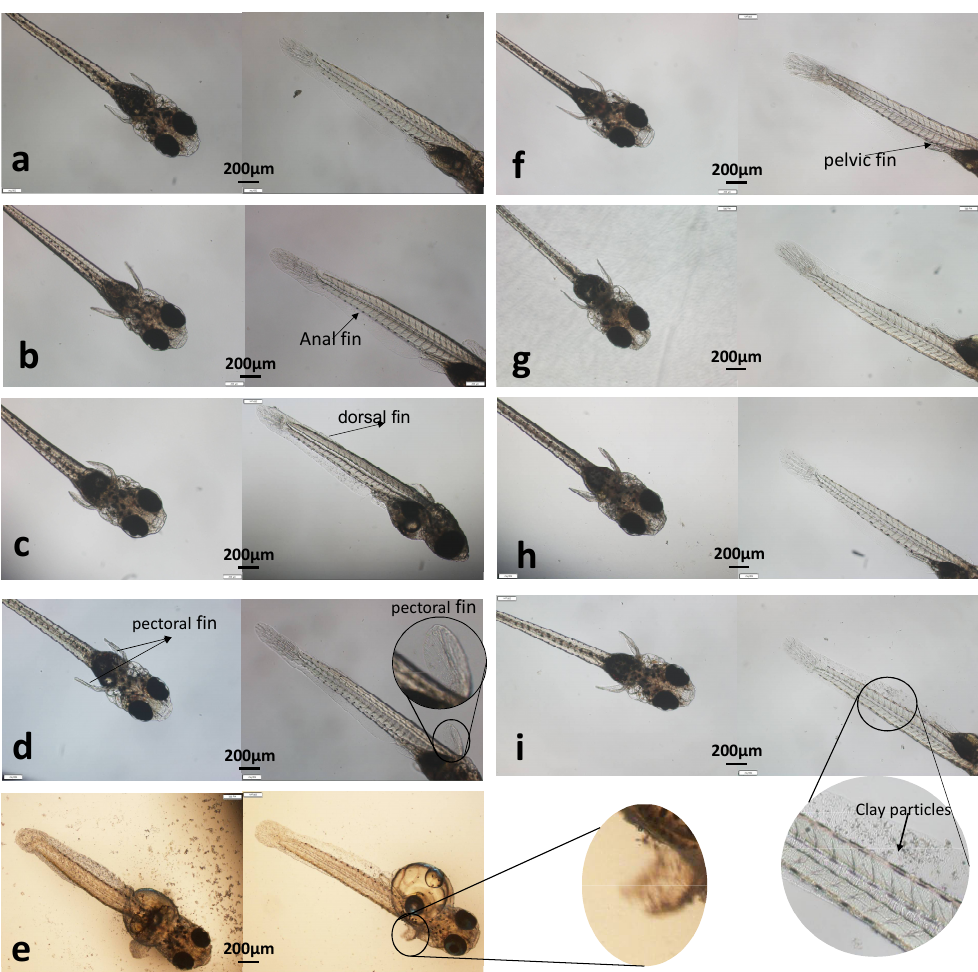
Figure 2. The external morphology of the newly hatched larvae of medaka at different time points. ( a – e ) Morphology of the larvae in the control, 0.2, 0.5, 2, and 7 g/L PAC-MC groups after the addition of modified clay for 6 h. ( A – D ) Morphology of the larvae in the control, 0.2, 0.5, and 2 g/L PAC-MC groups after the addition of modified clay for 96